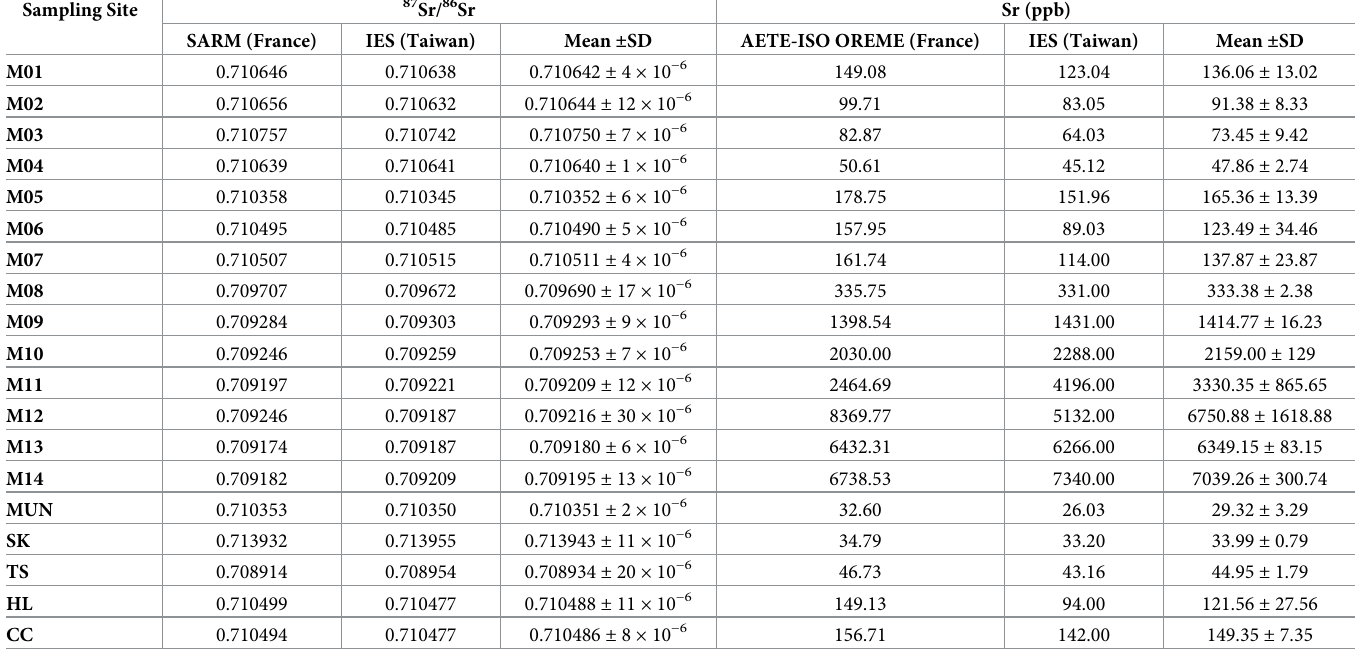
Table 2. 87 Sr/ 86 Sr and Sr concentrations.